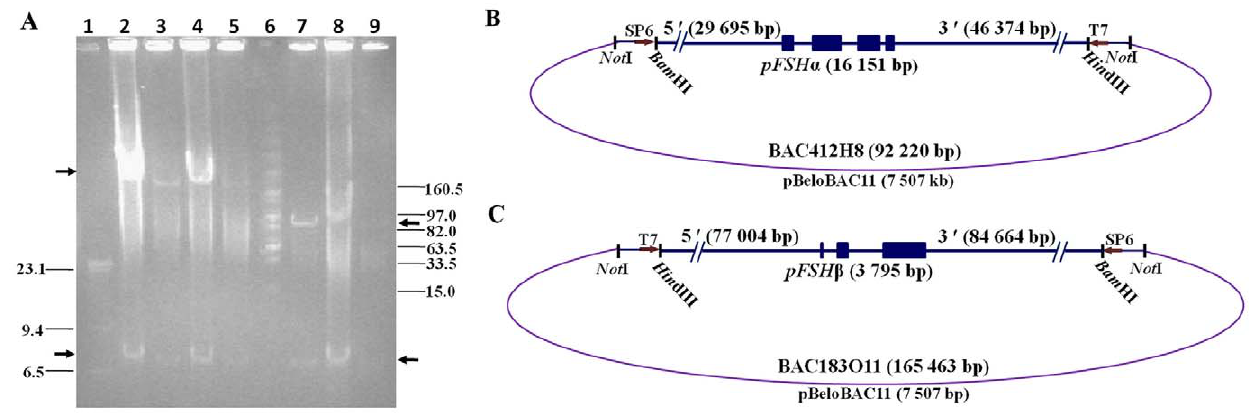
Figure 1. Pulsed-field gel electrophoresis (PFGE) and schematic representation of BAC clones spanning pFSH a and pFSH b . (A) Lane 1: l - Hin dIII marker; lanes 2–5: Not I-digested BAC183O11 DNA at different concentrations (3 m g, 0.2 m g, 1 m g, 0.1 m g); lane 6: MidRange II PFG marker; lanes 7–9: Not I-digested BAC412H8 DNA at different concentrations (0.2 m g, 0.8 m g, 0 m g); upper arrows, linear BAC bands; lower arrows, vector bands. (B–C) BAC clones were mapped by a combination of restriction endonuclease digestion, PFGE, direct DNA sequencing and alignment with the published gene sequence. Solid boxes represent gene exons and dashed lines represent two flanking sequences. The positions of the Not I restriction sites are indicated by the vertical bars.